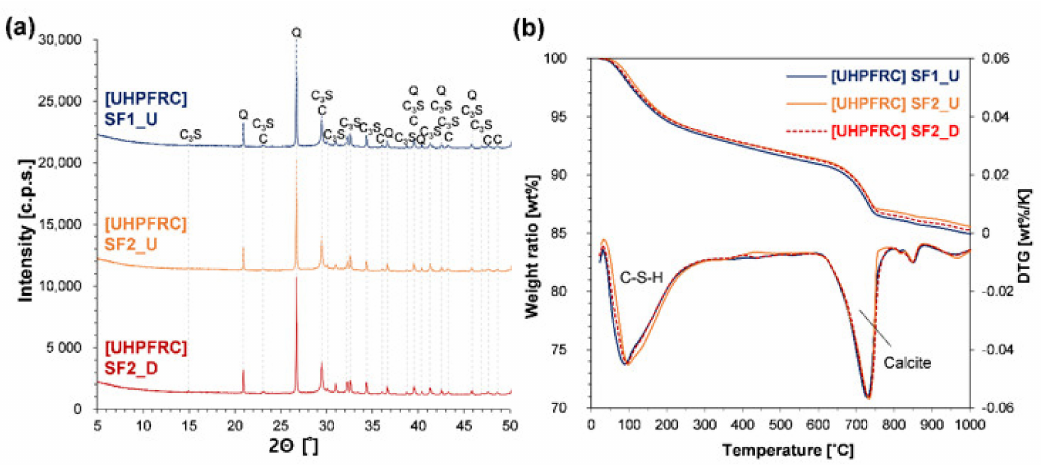
Figure 8. Analysis of crystal phases and hydration products of heat-treated paste samples: ( a ) XRD patterns at 28 days (Q: quartz, C: calcite, C 3 S: tricalcium silicate); ( b ) TG and DTG curves at 28